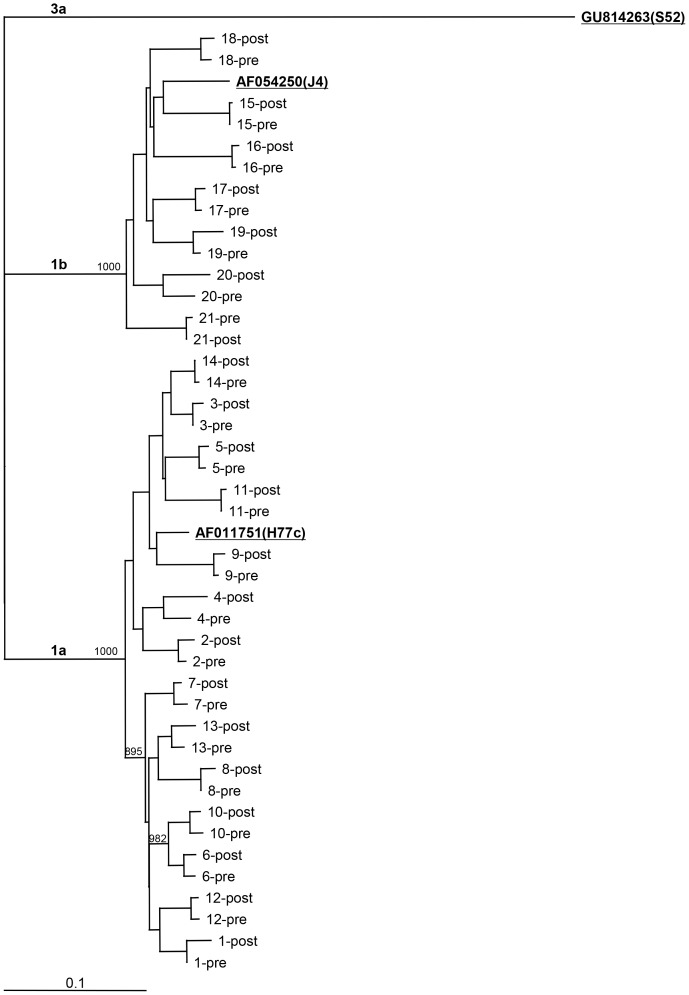
Phylogenetic tree of NS3-protease nucleotide sequences obtained by direct sequencing of pre- and post-treatment samples, for 21 selected genotype 1 patients with non-SVR analyzed for resistance variants.The tree was constructed by Neighbor-Joining with Kimura 2-parameter as the nucleotide substitution model. Support of nodes was based on bootstrap analysis (1000 replicates); only values over 850 are represented. The bottom horizontal bar represents 0.1 substitutions per nucleotide position. Reference strains for genotype 1a (H77C, AF011751), genotype 1b (J4, AF054250), and genotype 3a (S52, GU814263) are shown in bold and underlined. Genotype 3a, S52 was used as an out-group and root of the tree. Patients were grouped according to their genotype, 1a (n = 14), or 1b (n = 7). As expected, the pre- and post-samples taken from each individual patient clustered together, and bootstrap values of all final nodes were >850. No other significant clustering was observed.